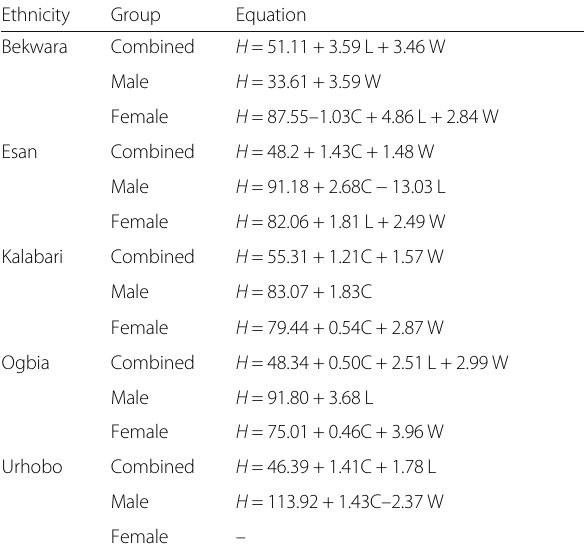
Table 9 Multiple regression models for height estimation from head dimensions Ethnicity